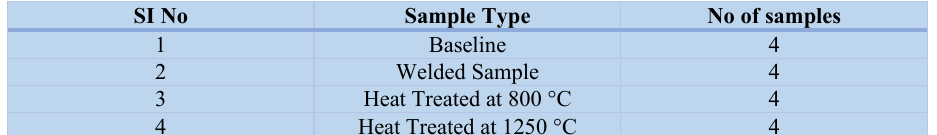
Table 1 : Sample Types used in this